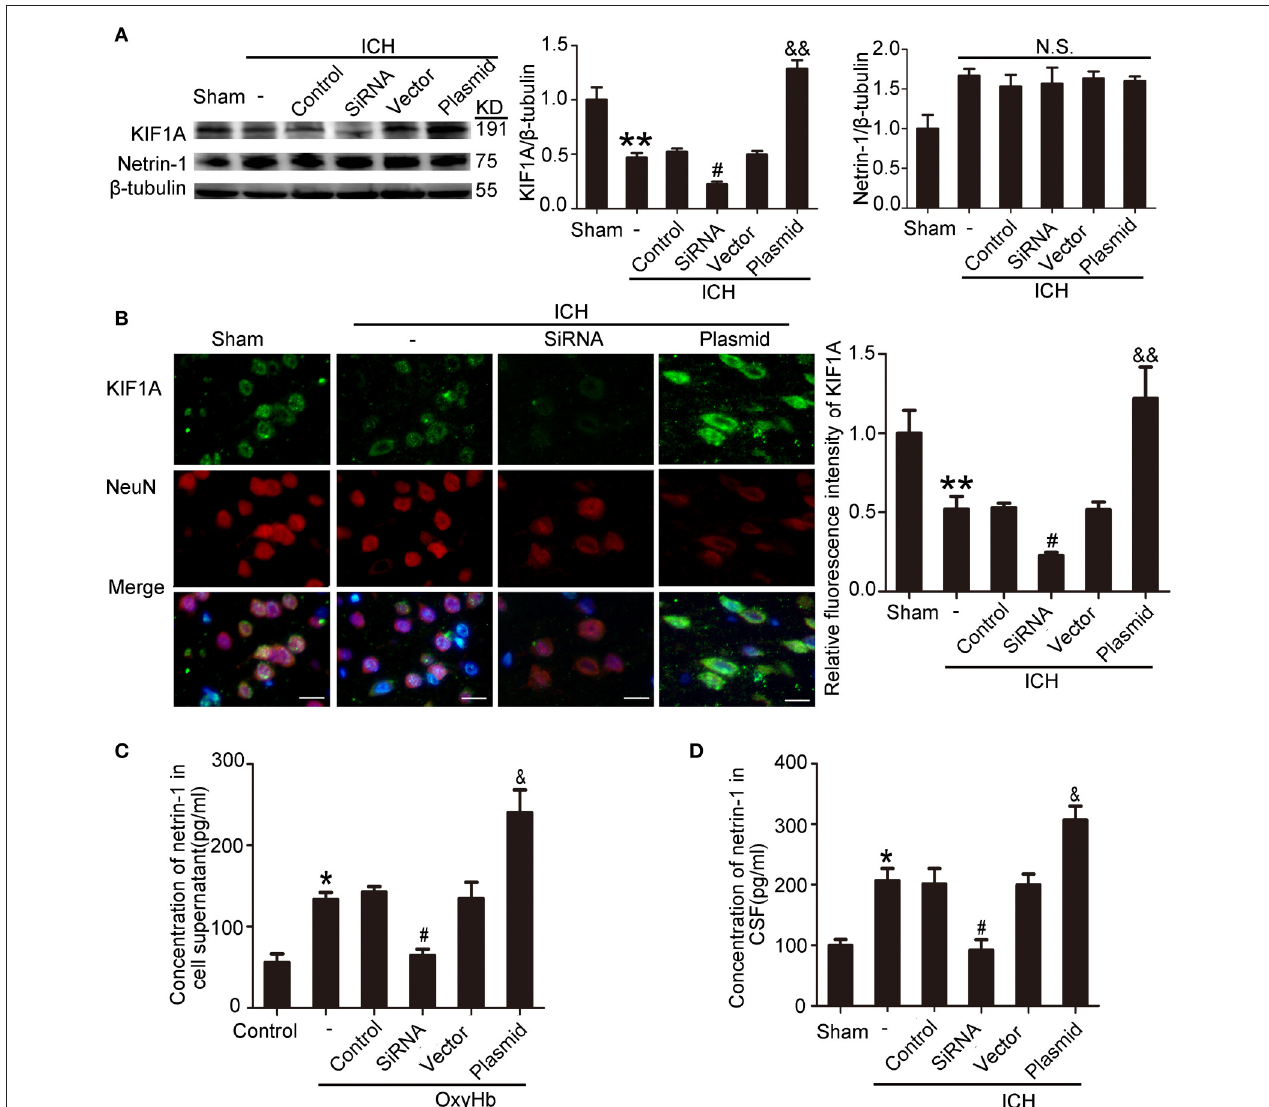
FIGURE 9 | Effects of KIF1A interventions on expression of KIF1A and netrin-1 after ICH-induced SBI. (A) Western blot analysis of KIF1A and netrin-1 protein levels in the peri-hematoma cortex. All values are expressed as mean ± SEM. Mean values of protein levels in the sham group were normalized to 1.0. ** p < 0.01 vs. the sham group, # p < 0.05 vs. the ICH + control siRNA group, && p < 0.01 vs. the ICH + vector group. N.S: no significant differences, n = 6. (B) Double immunofluorescence analysis was performed with KIF1A antibody (green) and NeuN antibody (red). Scale bar = 20 µ m. All values are expressed as mean ± SEM. The mean value of